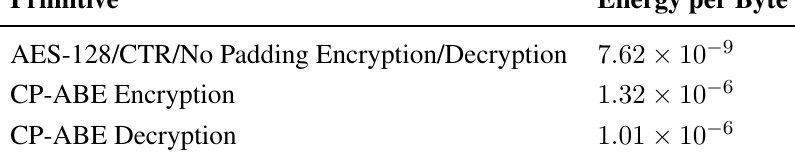
Table 1. Consumption (in Joules per byte) of symmetric and CP-ABE cryptographic primitives.